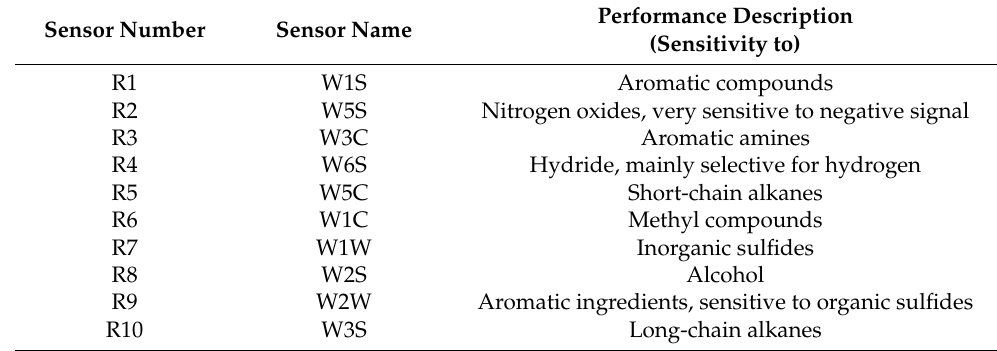
Table 1. The main compounds detected by different chemical